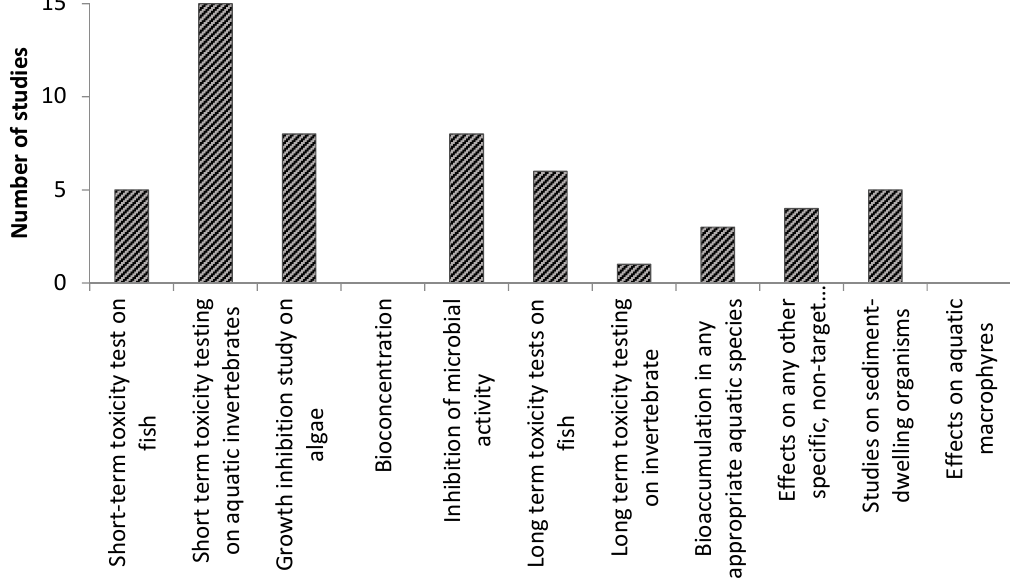
Figure 1. Number of studies potentially fulfilling the Biocidal Product Regulation (BPR) information requirements for ecotoxicity tests.